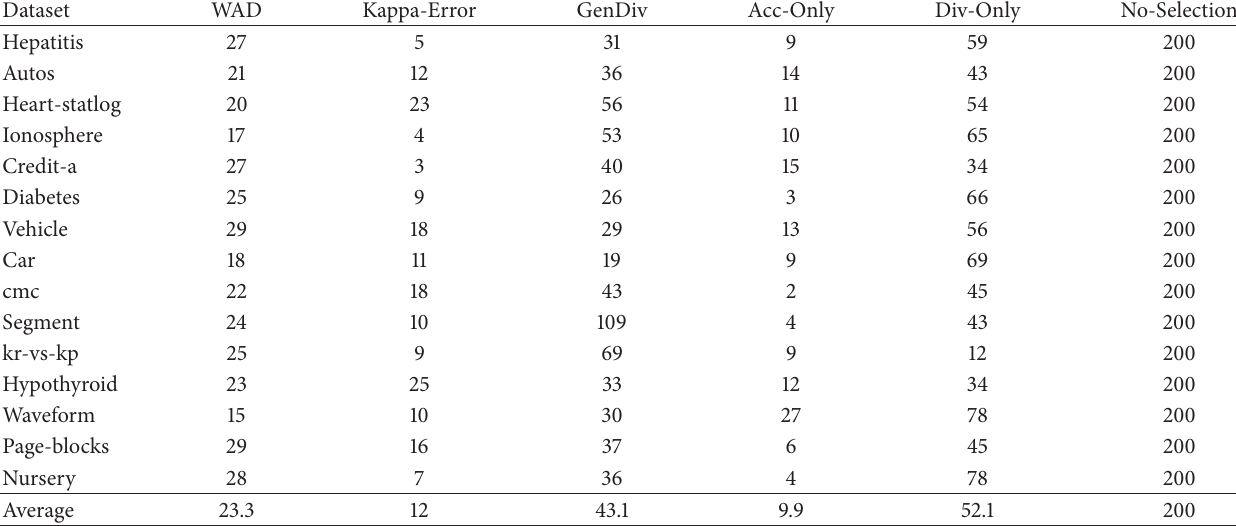
Table 4: The average size of subensembles selected by candidate measures and